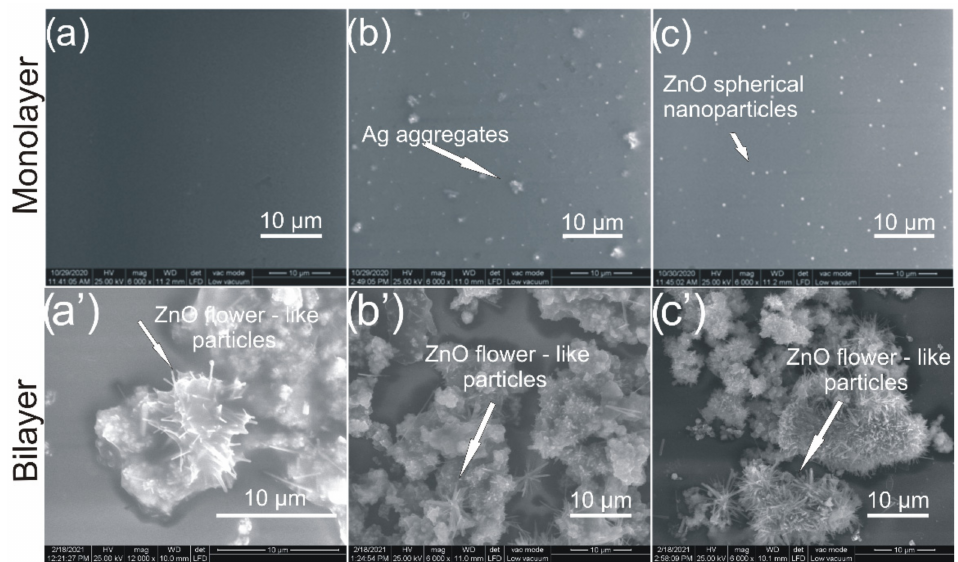
Figure 1. SEM images of the mono- and bilayer coatings deposited on glass slides: ( a ) A0-I; ( a’ ) A0-II; ( b ) AOAg-I; ( b’ ) AOAg-II; ( c ) AOZnO-I; ( c’ )